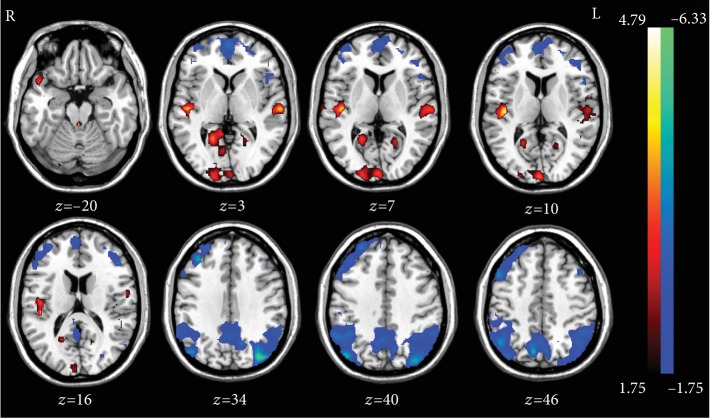
Comparison of the ALFF between SD and NS. The decreased spontaneous neural activity (blue color) after SD mainly located in the default mode network-related brain regions including the posterior cingulate cortex, precuneus, angular gyrus, medial prefrontal cortex, and inferior parietal cortex (p < 0.05, Alphasim-corrected).